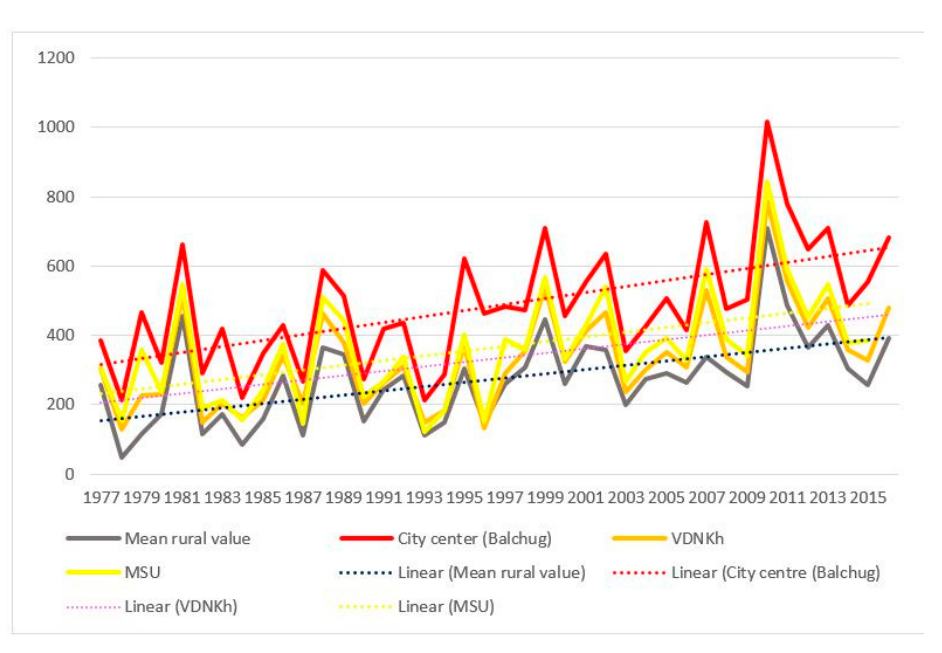
Table 1. The extent of favorability of meteorological conditions for autochthonous transmission of malaria.